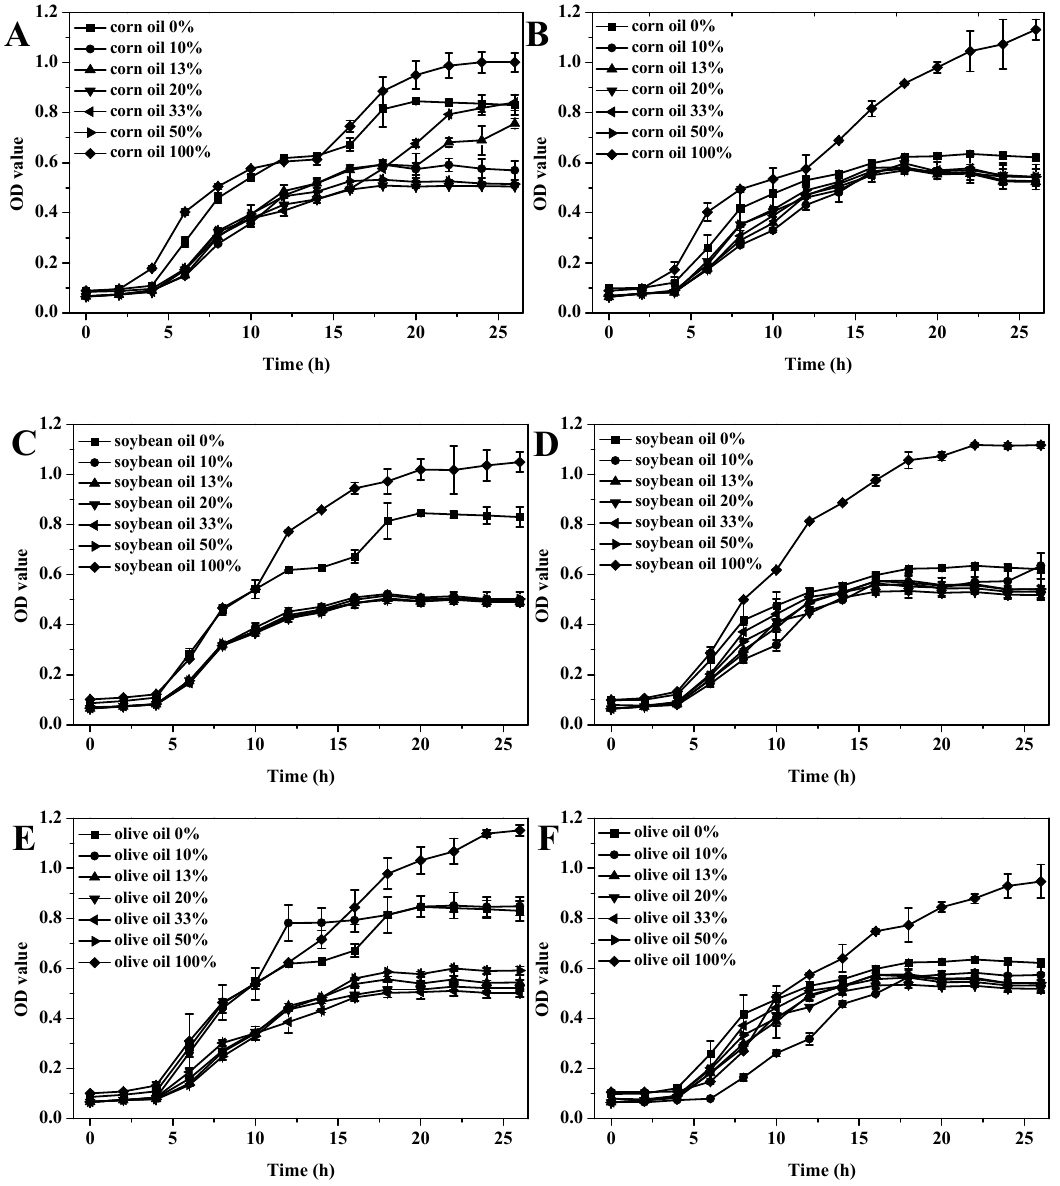
Figure 4. Growth curves of E. coli treated by GEO-CO ( A ), GEO-SO ( C ) and GEO-OO ( E ) microcapsules and S. aureus treated by GEO-CO ( B ), GEO-SO ( D ) and GEO-OO ( F ).